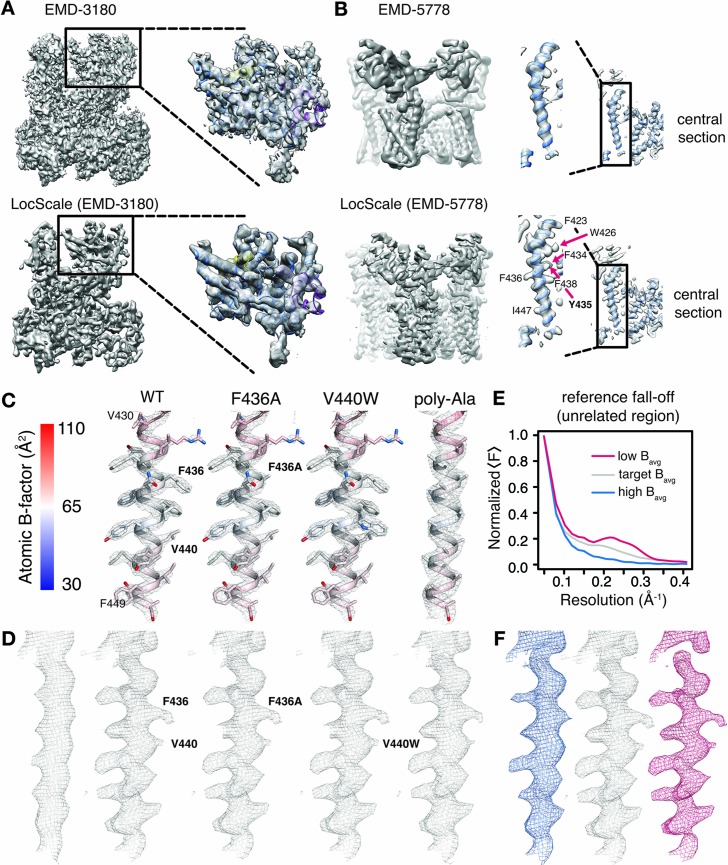
Optimized cryo-EM map contrast by local model-based amplitude scaling (LocScale) and assessment of model bias.(A) and (B) Illustration of the LocScale sharpening for initially over-sharpened (A), RNA Pol III; EMD-3180) and under-sharpened maps (B,) TRPV1; EMD-5778). The maps after application of global (Guinier) sharpening (top) are shown in comparison with its LocScale equivalent (bottom). The LocScale map contains recognizable secondary structure. Zoomed-in inset: (A) The globally sharpened map shows undue noise amplification rather than true molecular features of the peripheral subunits as visualized in the LocScale map. Central section: (B) When global sharpening levels were underestimated, LocScale map reveals previously invisible features such as defined side chain densities (arrows). (C) Mesh representation of simulated reference densities for TRPV1 residues 430–449 for wild-type (WT), F436A, V440W and poly-alanine mutants superposed on the respective atomic model. Atoms are colored by atomic B-factor with B-factor scale as defined on the far left. (D) Mesh representation of density for residues 430–449 as deposited in EMD-5778 (far left) and LocScale maps obtained by sharpening using WT, F436A, V440W and poly-alanine mutants as a reference maps. The order follows that in (C). (E) Radial amplitude profile of a structurally unrelated region used as reference window for scaling with high (blue), target (grey) and low (red) average B-factors. The respective regions are shown in Figure 3—figure supplement 1. The denotation high and low refers to the average B-factor across the reference window compared with that estimated for the target window. (F) Densities for residues V420-F449 obtained after scaling using the reference falloffs in (E) with equivalent color-coding.